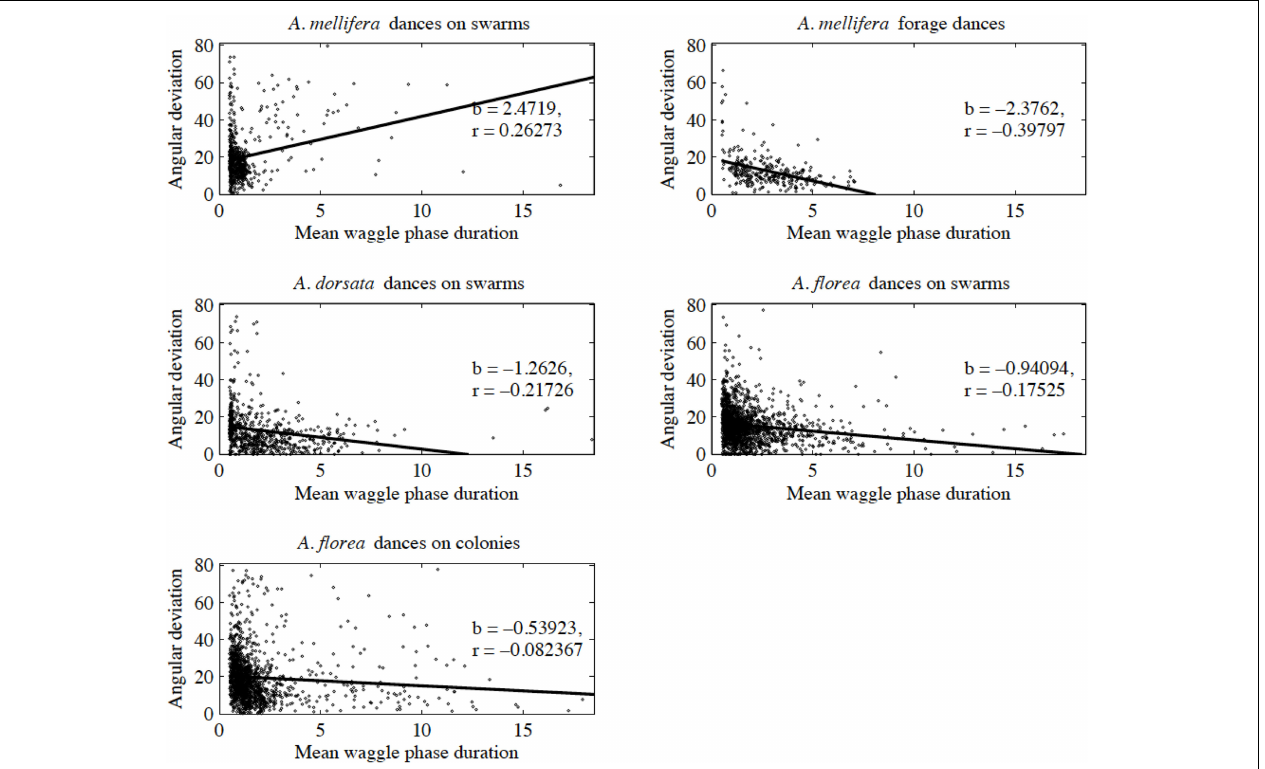
FIGURE 2 | Angular deviation plotted against mean waggle phase duration. Each dot represents the mean of all waggle phases within one dance performed by a bee. The solid line is the line of best fit determined by ordinary least squares regression (see Table 1 for details of the linear regression analyses).